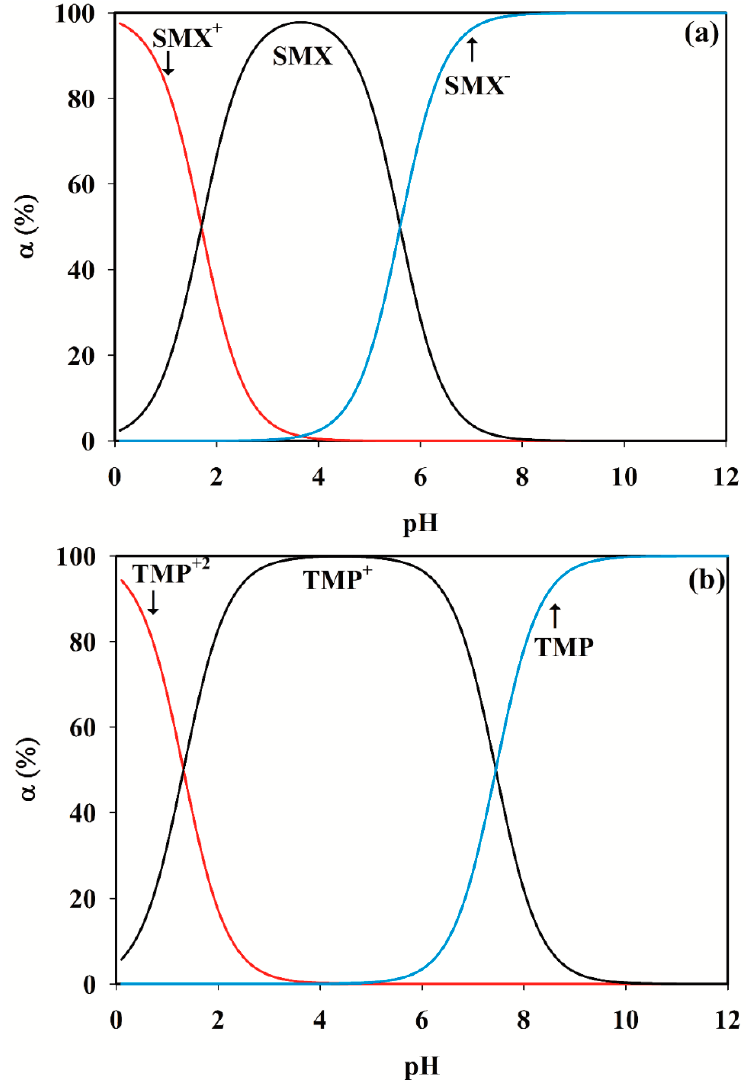
ff erent pHs for: ( a ) sulfamethoxazole; and ( b ) Figure 4. Distribution of species at different pHs for: ( a ) sulfamethoxazole; and ( b ) trimethoprim. Figure 4. Distribution of species at di